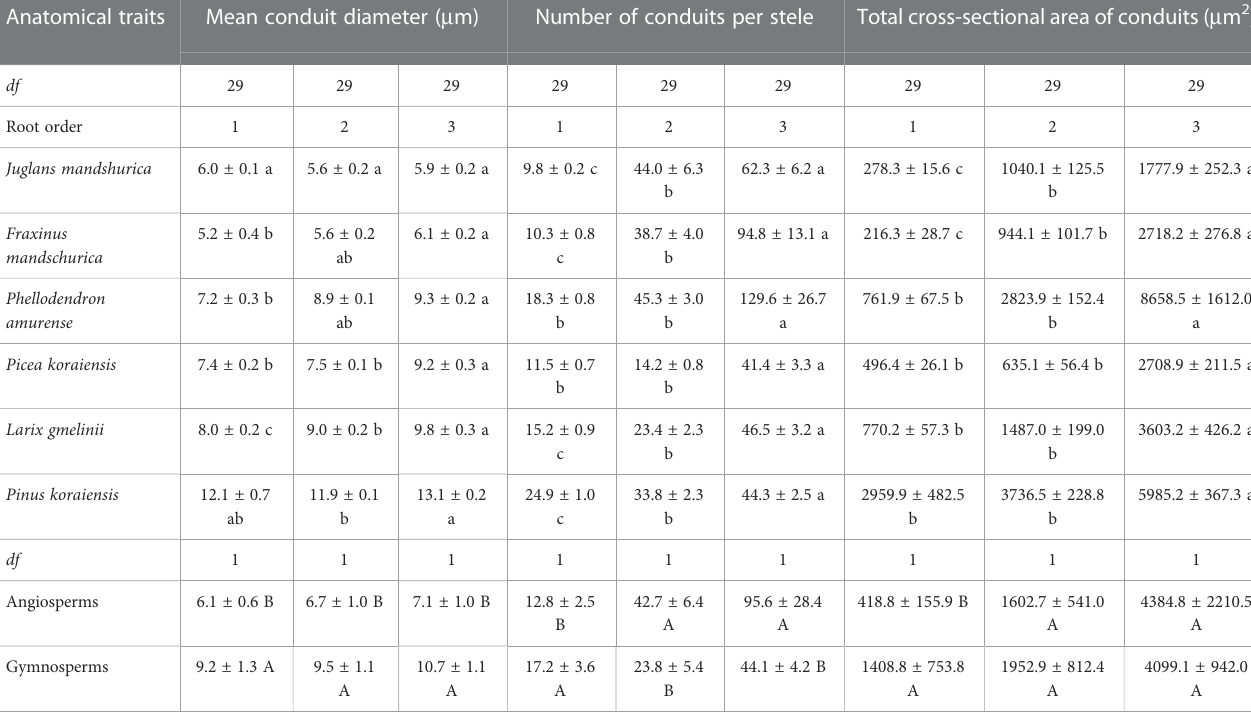
TABLE 1 The mean and standard error of conduit traits for the fi rst three absorptive root orders in three angiosperms and three gymnosperms tree species ( n = 30). Anatomical traits